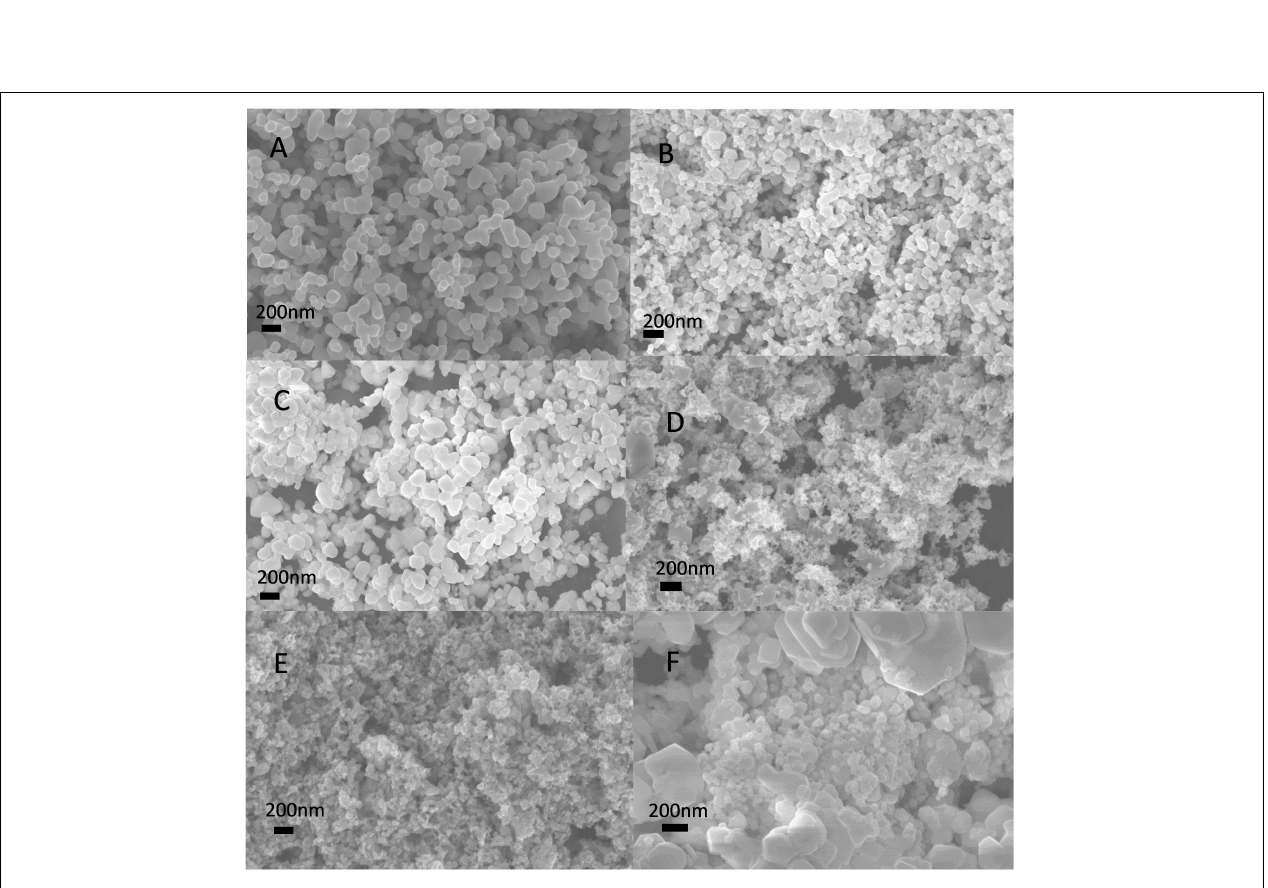
FIGURE 2 | SEM images of the LSCO samples: (A) LSCO0%, (B) LSCO5%, (C) LSCO10%, (D) LSCO20%, and (E) LSCO30% synthesized via the combined sol–gel and molten-salt procedure, and (F) LSCO0% via the conventional sol–gel process with direct calcination.